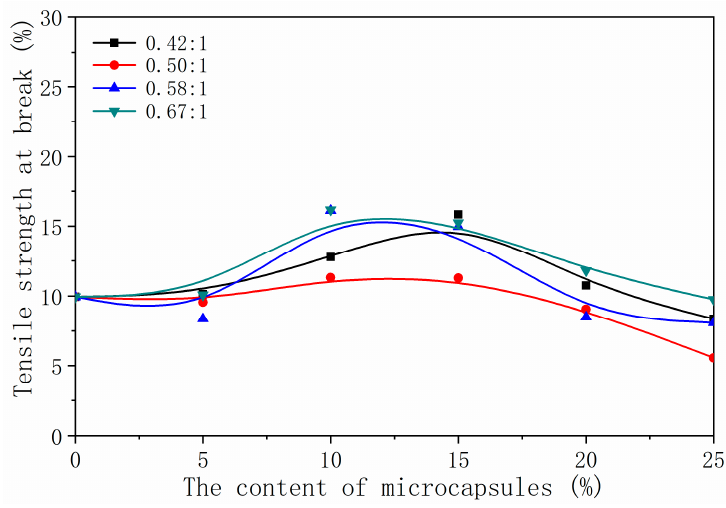
Figure 2. Variation of elongation at break of water-based topcoat paint